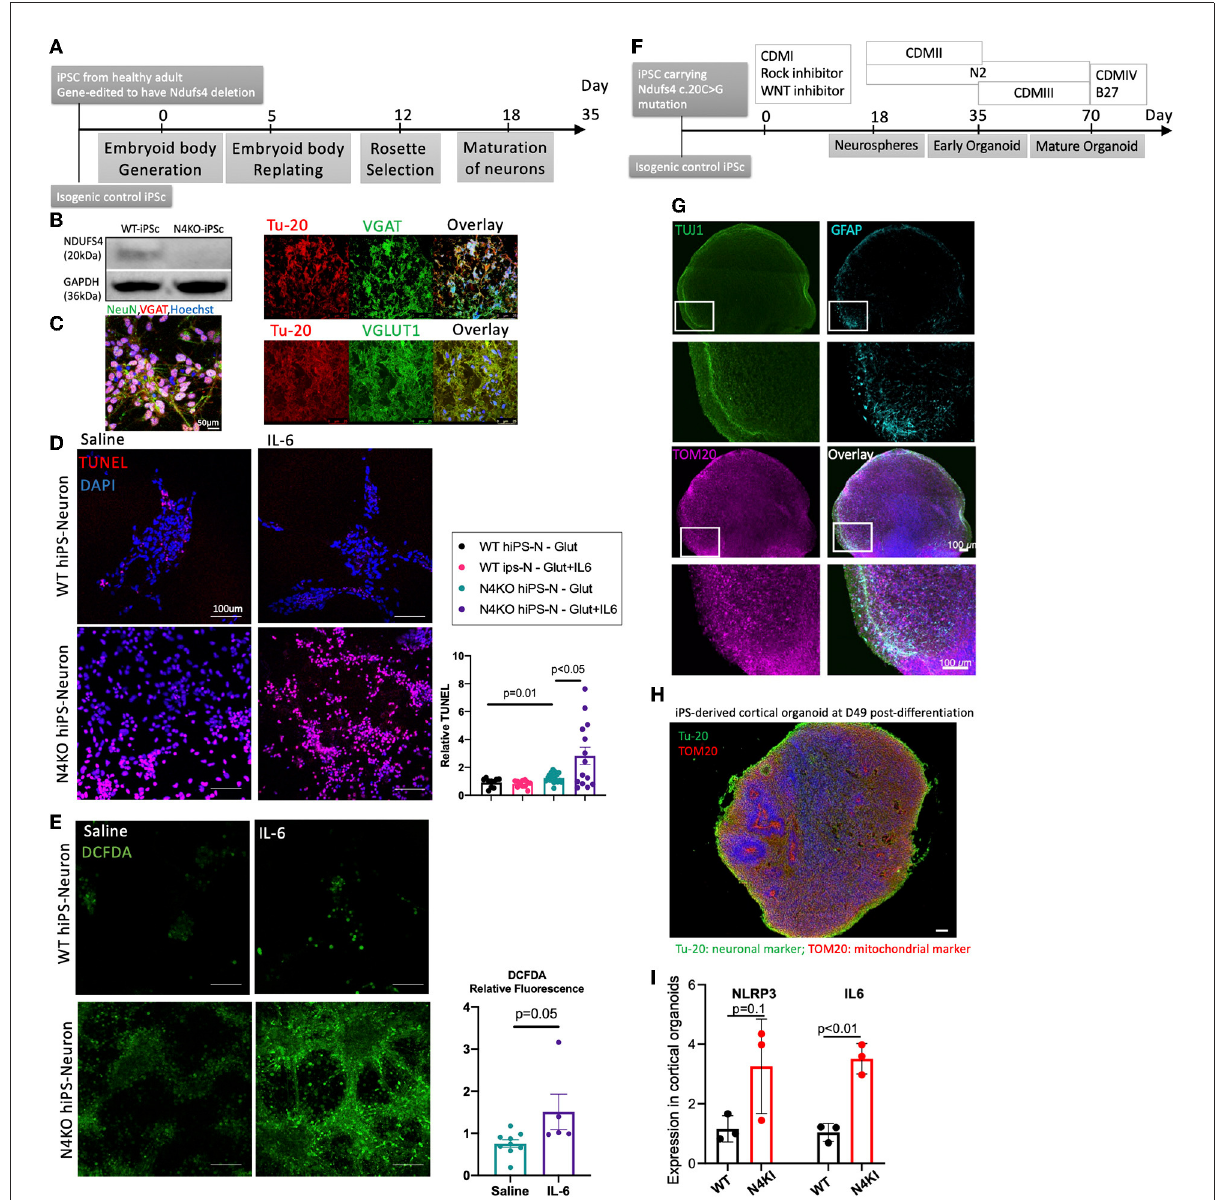
FIGURE4 (A) Steps to generate iPS-derived neurons. (B) Immunoblotting of Ndufs4 in WT-hiPS and Ndufs4KO (N4KO)-hiPS. (C) Characterization of human iPS-Ns by immunofluorescence for neuronal nuclear protein (NeuN), pan-neuronal marker b-Tubulin (Tu-20) showing mixed neurons positive for vGAT (vesicular GABA transporter) or vGlut1 (vesicular glutamate transporter). (D) TUNEL assay (red) counterstained with DAPI (blue) in WT- and N4KO iPS-neurons treated with glutamate (30 µ m), IL-6 (50 µ m). (E) DCFDA live staining of N4KO iPS-Neurons treated with Saline or IL-6. The significance is calculated by ANOVA Sidak post-hoc analysis or t -tests. (F) Brief protocol to generate iPS-derived cortical organoid. (G, H) Representative image of a cortical organoid at day 49 post-differentiation, showing Tuj1 (class III beta-tubulin) for neurons, GFAP (glial fibrillary protein) for astrocytes, TOM-20 staining for mitochondria and Tu-20 staining for neurons. (I) Normalized expression of mRNA of NLRP3 and IL6 in cortical organoids at day 80 derived from iPSCs in which we knocked in the mutation c.20C > G in the NDUFS4 gene (N4KI, in red) presented as fold-change compared with isogenic control iPSCs (WT); n = three technical replicates, mean + standard deviation; significance by t